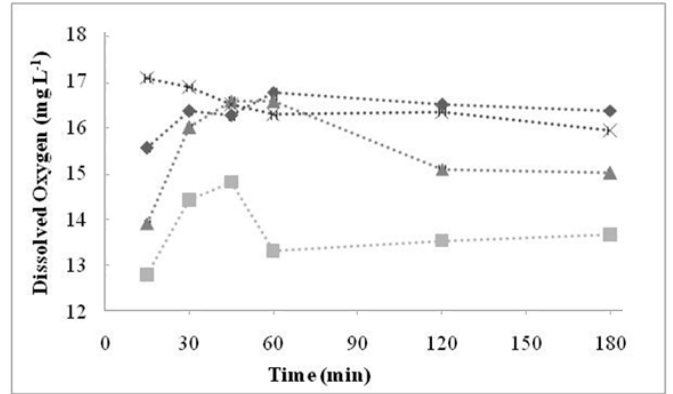
Figure 1. Total Organic Carbon as a function of time. Condition ([FeSO 4 ·7H 2 O] 0 , mmol L − 1 ): ( ) 25; ( ) 50; ( ) 100; ( ) 150.